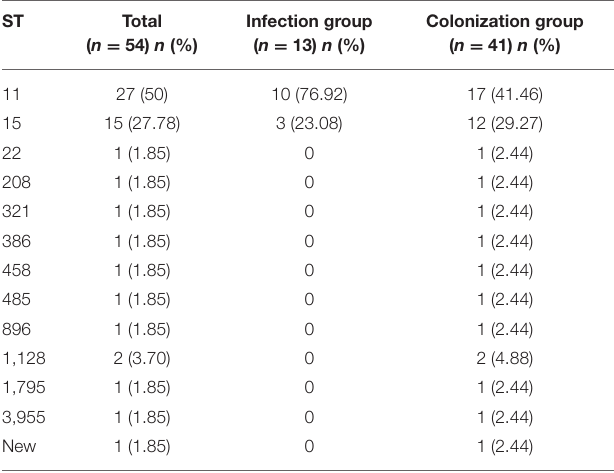
TABLE 5 | Genotypes and distribution of K. pneumoniae isolates.